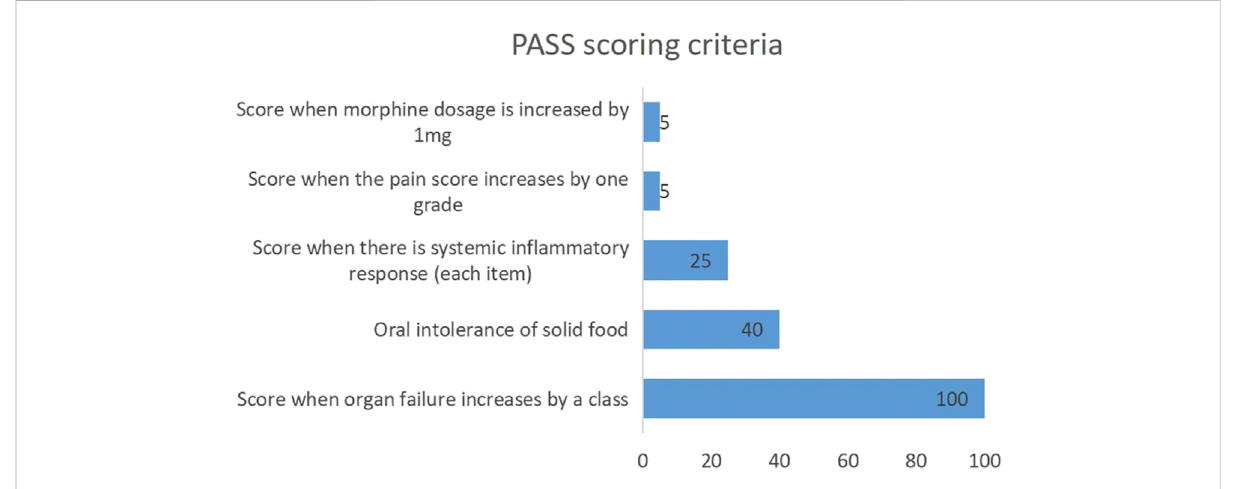
FIGURE 1 PASS scoring criteria. PASS: pancreatitis activity scoring